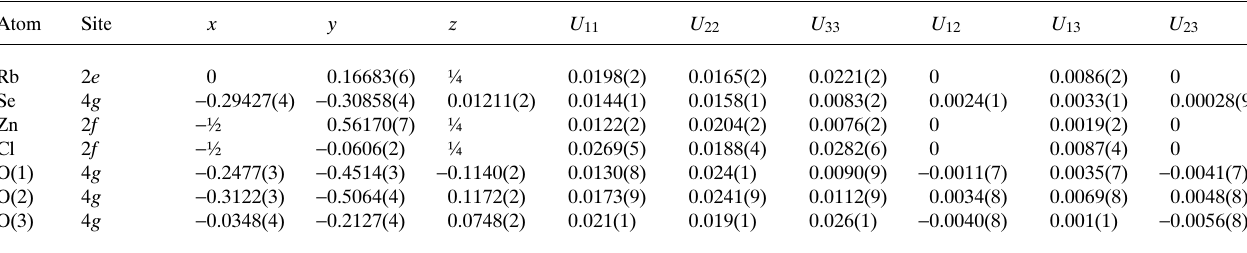
Table 3. Atomic coordinates and displacement parameters (in Å 2 )